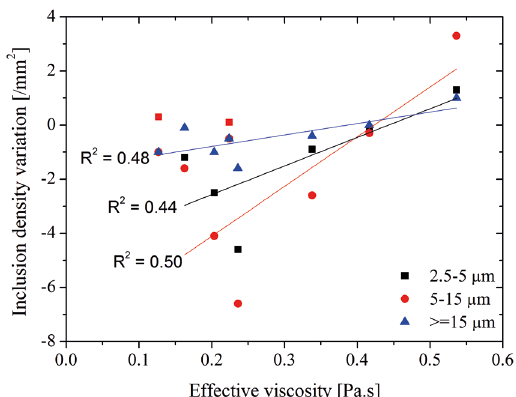
Figure 9. Inclusion density variation related to the effective viscosity of all slag samples at 1600 °C.